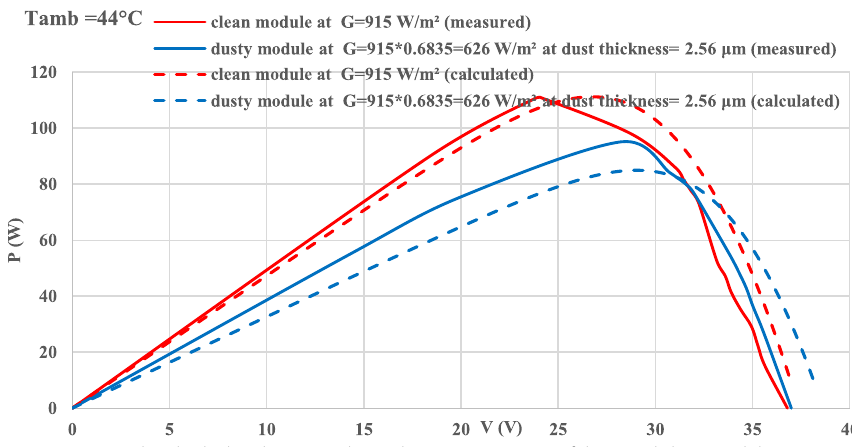
Fig. 10 Measured and calculated power‑voltage characteristic curves of dusty and clean modules at ambient incident radiation of 915 W/m 2 https:// www. trnsys. com